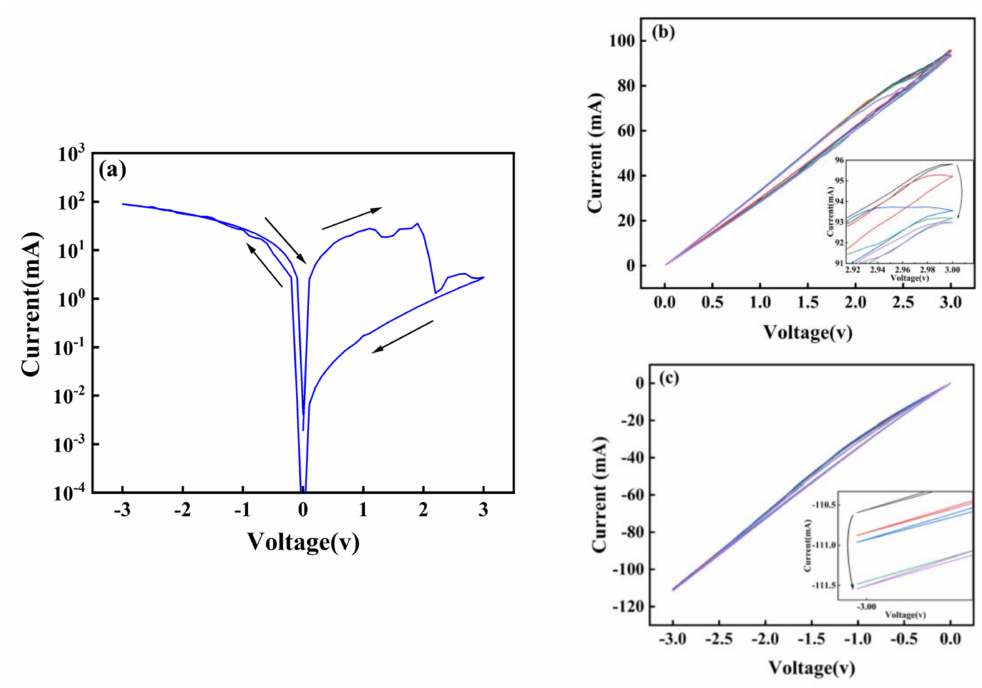
Figure 4. ( a ) The memory switching measurement of the Au/CsPbI 3 /ITO artificial synapse. The memory behavior of the Au/CsPbI 3 /ITO artificial synapse is measured by ( b ) five positive scanning voltage and ( c ) five negative scanning